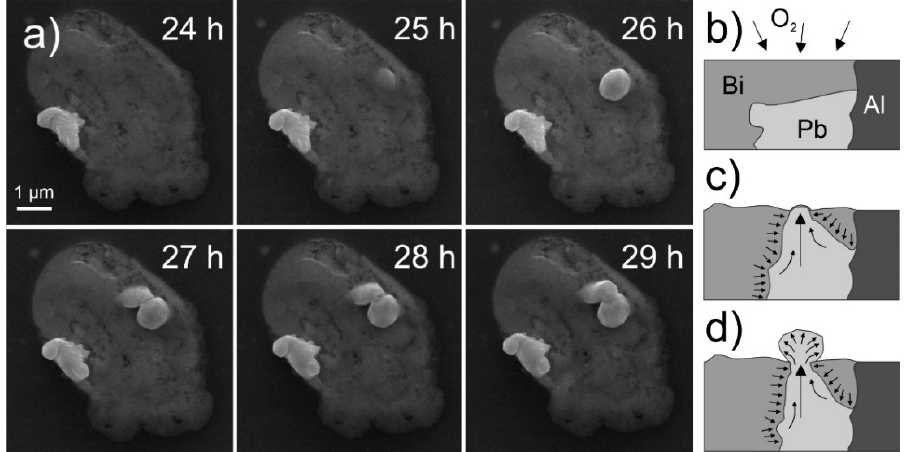
Figure 8. ( a ) Sequential images displaying hillocks growth formed from Pb regions situated underneath the Bi-Mg material of the pool. The timestamp denotes the time from the final sample surface preparation. ( b – d ) Schematic representation of the formation of facetted-bubble hillocks from a Bi-Mg-Pb pool with underlying Pb region. The arrows in ( b , c ) represent the movement of the material and the pressure state of the individual material segments.